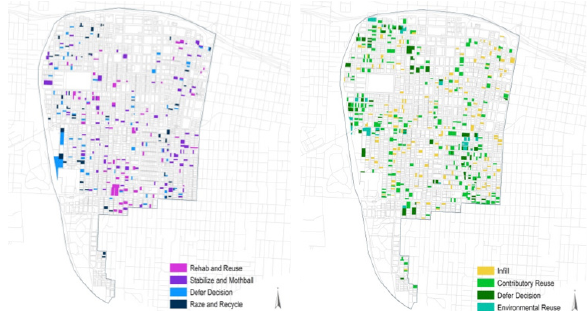
Figure 6. Relocal recommendation maps for vacant buildings (left) and vacant lots (right) in the neighborhood surrounding Central High School in Little Rock, Arkansas (Source: PlaceEconomics,